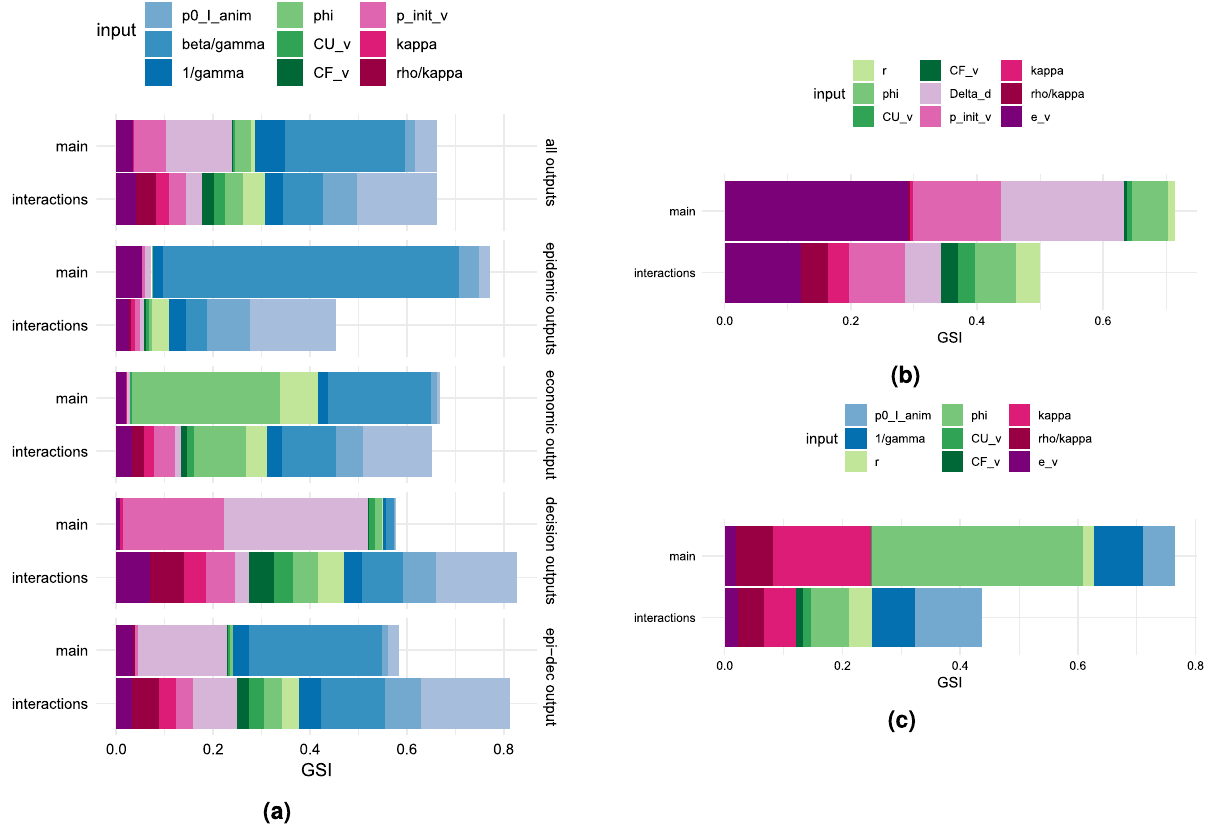
Figure 5. Global Sensitivity Indices (GSI) for the means over runs of the outputs considered in each experiment. Sensitivities are split in main effect and two-factor interactions. Blue colors correspond to epidemic parameters, green colors to economic parameters, and pink colors to decision-related parameters. ( a ) GSI for the means of all outputs, and by group of outputs in experiment (i). ( b ) GSI for the means of all outputs in experiment (ii). ( c ) GSI for the means of decision outputs in experiment (iii). See Table 1 for parameters definition, and Table 2 for outputs